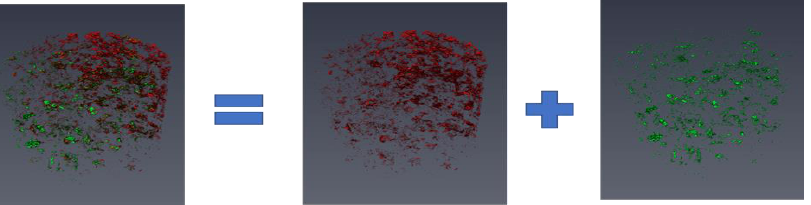
Figure 16. Y53 – 89 core after the 2nd water flooding (green is the injected water and red is the remaining oil after water flooding).